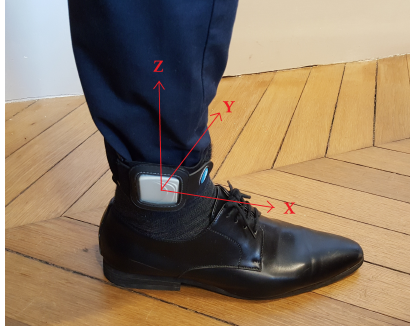
Figure 3. Default device